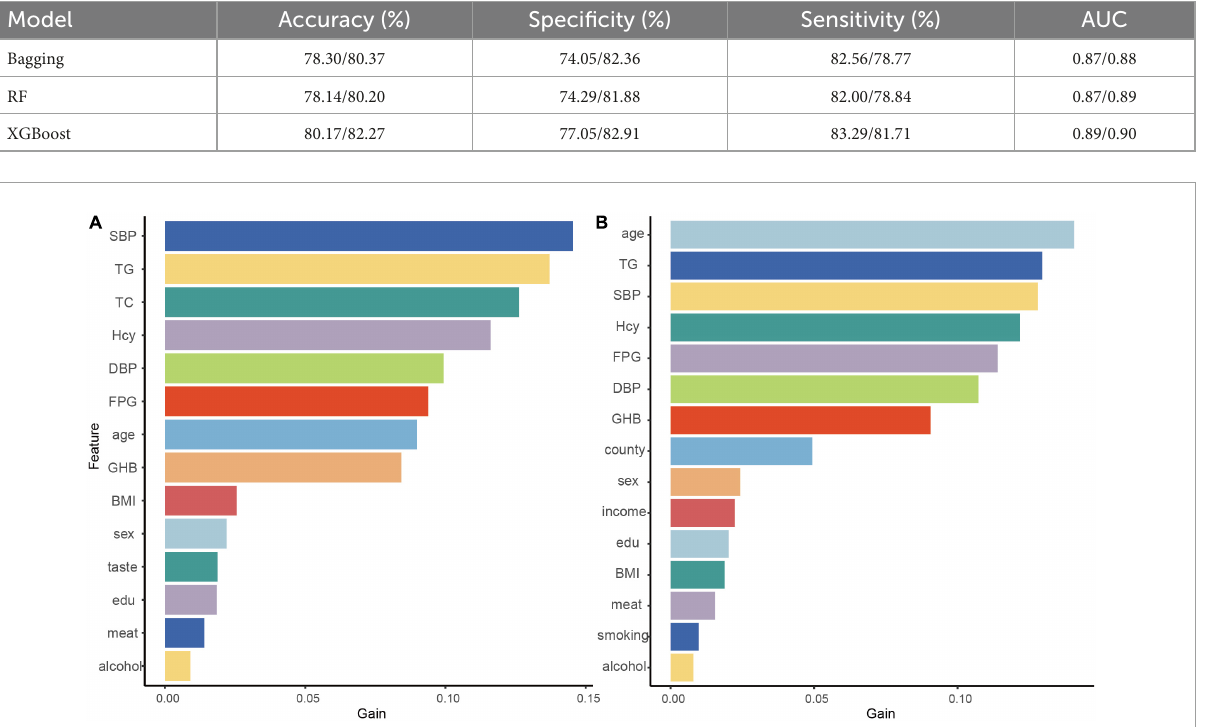
FIGURE4 Contributions of explanatory variables to the XGBoost algorithm. The “Gain” means the relative contribution of the corresponding feature to the model calculated by taking the contribution of each feature to each tree in the model. The high value of this metric compared to other characteristics means that it is more important for generating predictions. Therefore, a larger value indicates that the variable is more important; ACR outcomes (A) and MCR outcomes (B) .